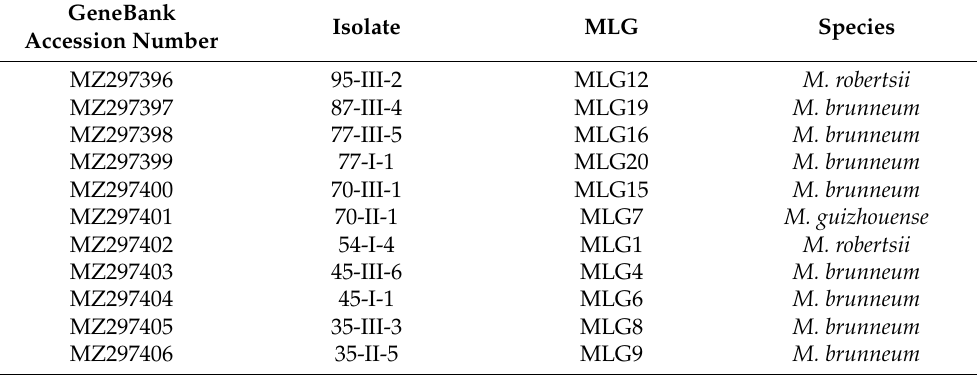
Table A1. GenBank accession numbers of the EF1a sequences used to construct the phylogenetic tree in Figure 3 of one representative isolate per